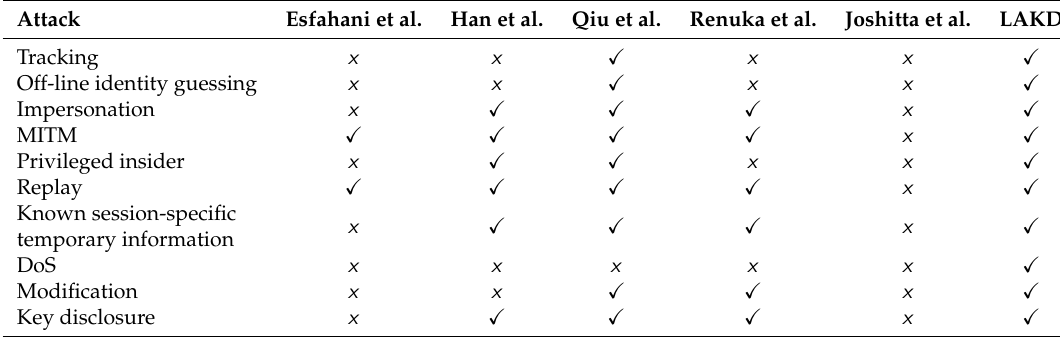
Table 8. Comparison of the protocols’ resistances to